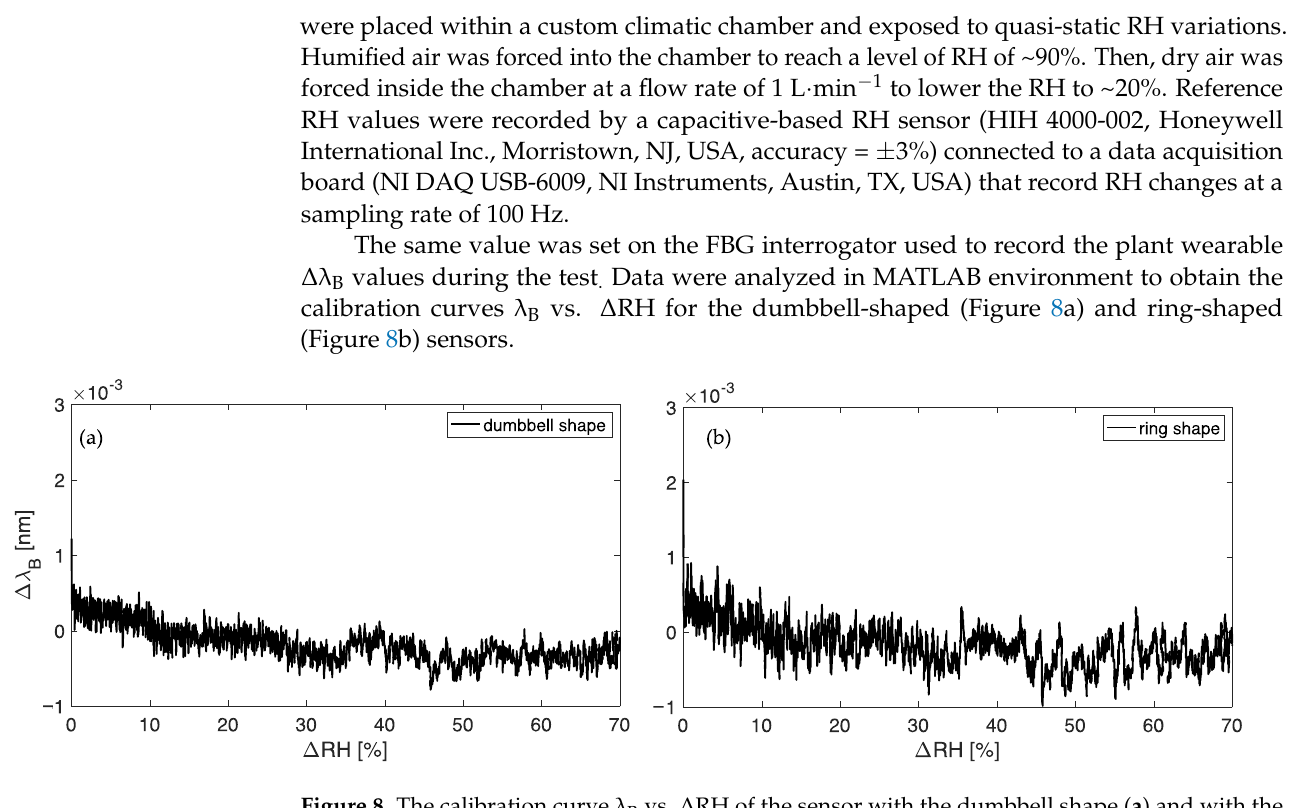
Figure 7. The calibration curve  λ B vs.  T of the sensor with a dumbbell shape ( a ) and a ring shape ( b ).